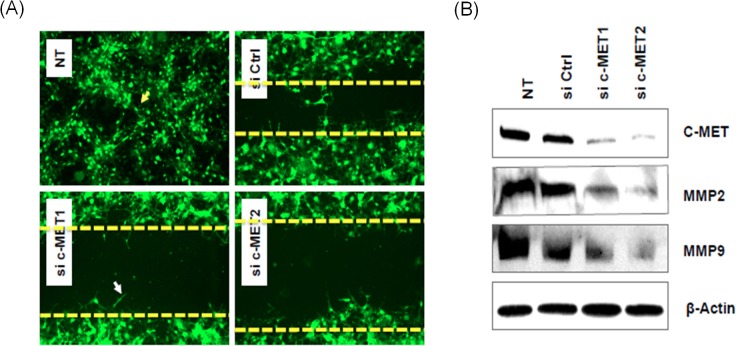
MMP2 and MMP9 may be downstream effectors of c-MET knockdown, leading to suppression of migration in T24 bladder cancer cells.(A) Wound-healing assay showing that knockdown of c-MET inhibitsthe migration of T24 cells. (B) Loss of c-MET downregulated the expression of matrix metalloproteinases (MMP)-2 and MMP-9. All experiments were performed using two c-MET knockdown cell lines (sic-MET-1 and sic-MET-2) transfected with different MET siRNAs, and two control cell lines (Ctrl and NT). Ctrl, control; NT, non-transfected.